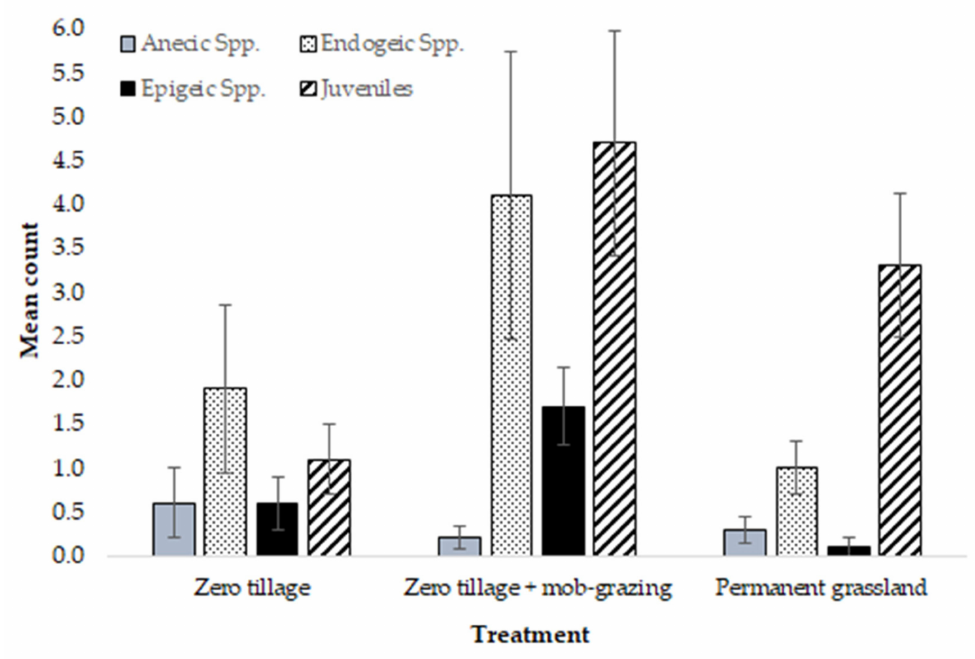
Figure 2. Mean count of earthworm functional group for three treatments (ZT: zero tillage; ZTMG: zero tillage + mob-grazing; PG: permanent grassland), n = 10 per treatment. Error bars ± one standard error of the mean. Table 3. Mann–Whitney test statistical output for three treatments [* p (Asymp.sig) ≤ 0.05; ** p (Asymp.sig) ≤